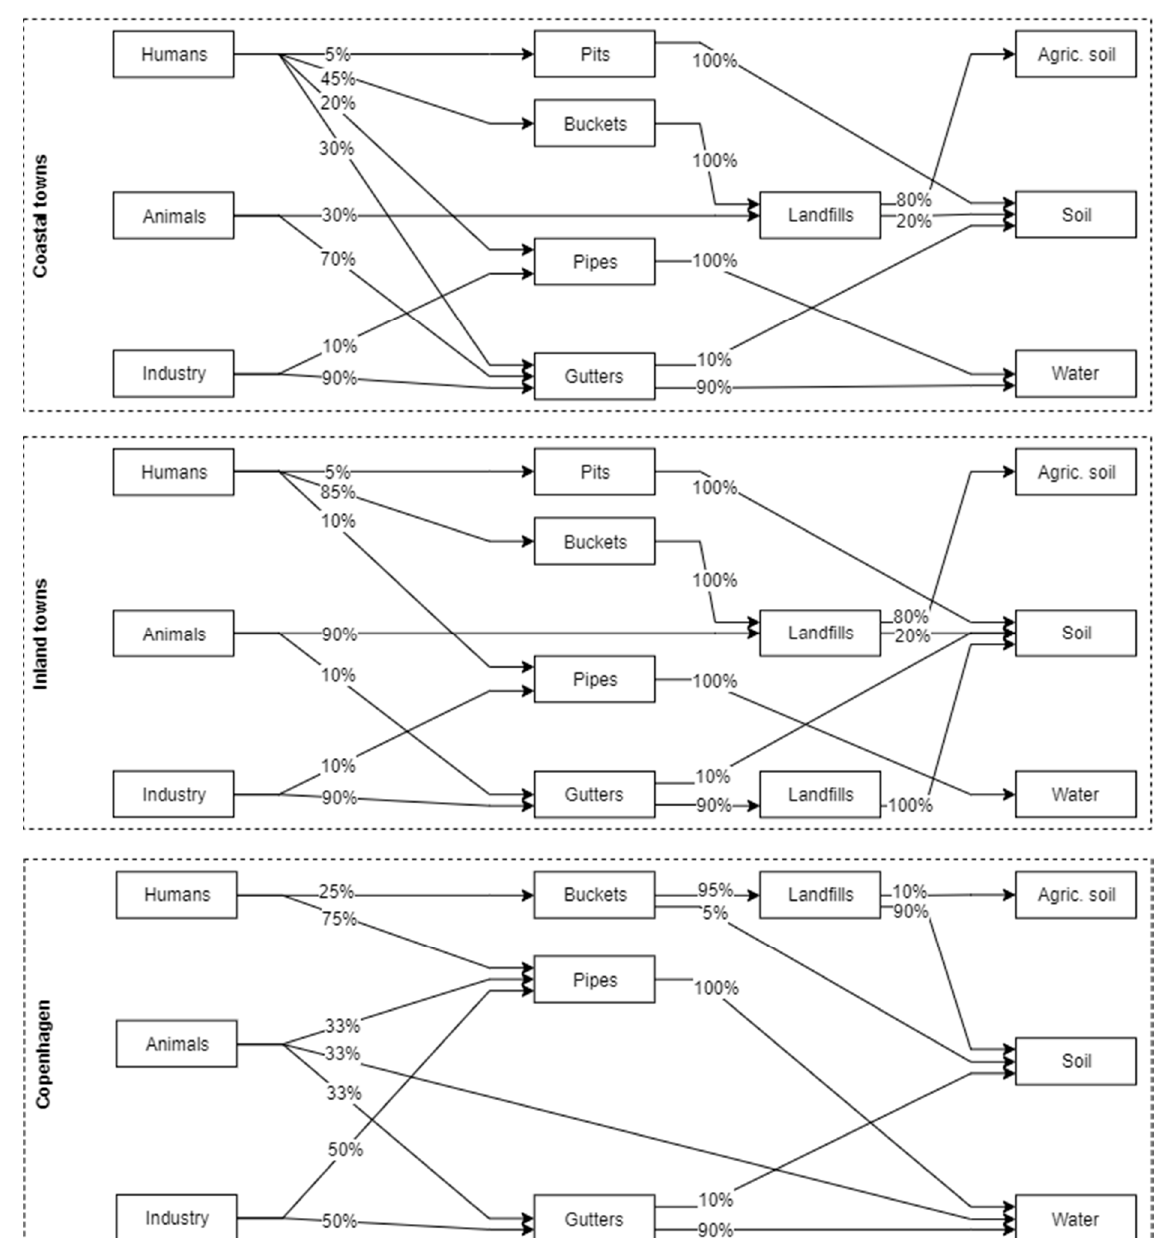
Figure 3. Estimated flows of excrements from humans and animals and wastewater from industries in Danish coastal and inland towns and in Copenhagen in 1900.